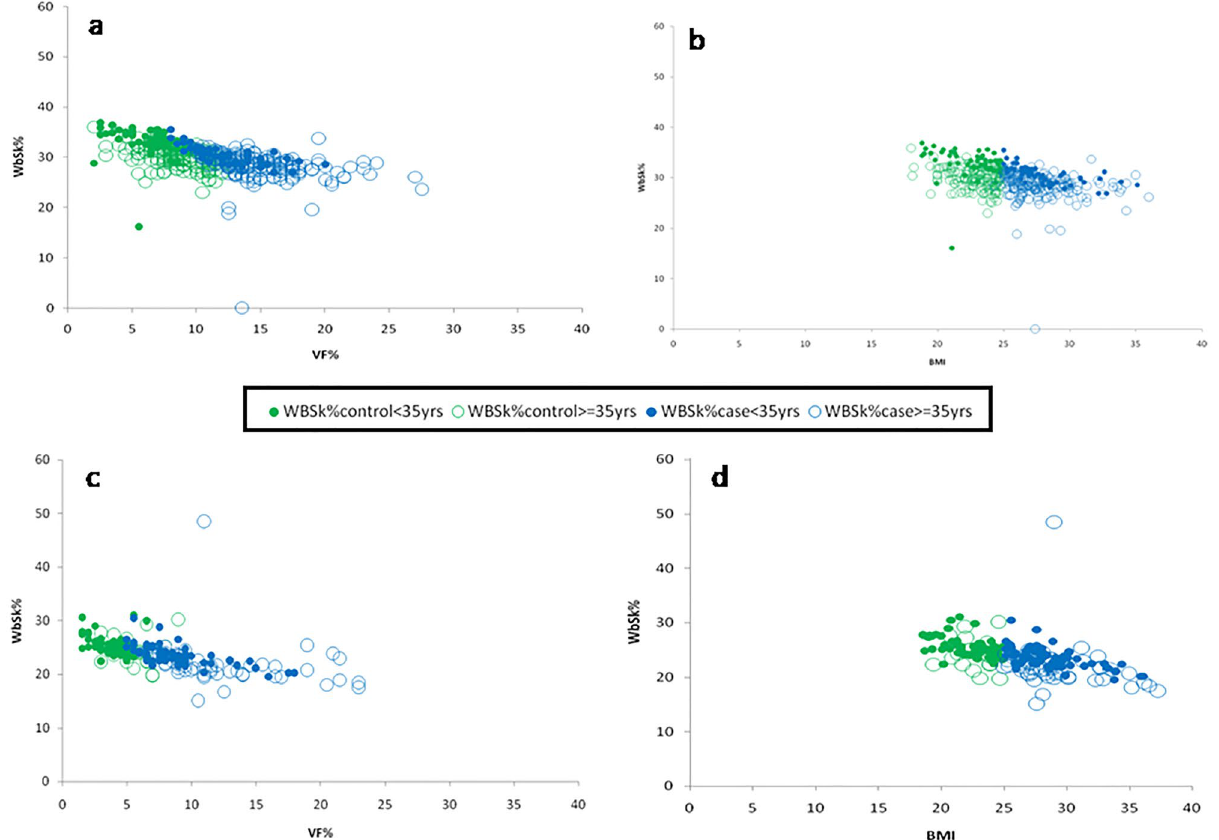
Figure 2. Association between (i) VF% and WbSk% ( a & c ) (ii) BMI and WbSk% ( b & d ) in the total male and female population